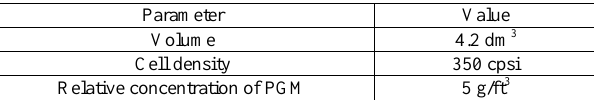
Table 1. Parameters of DPF under